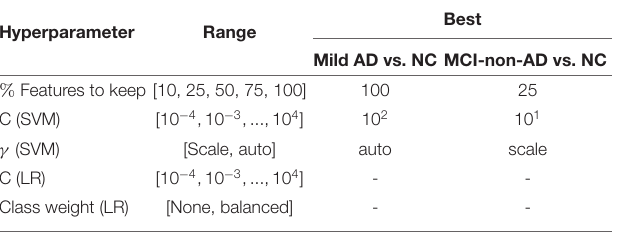
TABLE 2 | Hyperparameter values inspected using grid-search cross-validation. Hyperparameter